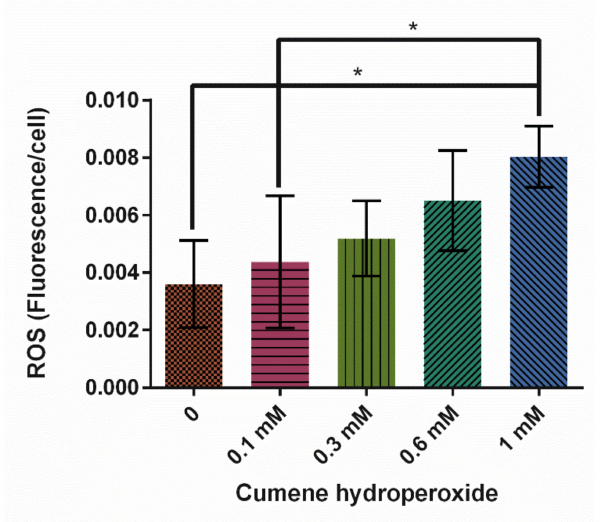
Figure 2. Effect of cumene hydroperoxide on average reactive oxygen species (ROS) levels in D. discoideum ± SE ( N = 5). Cumene significantly increased ROS levels as indicated by * ( p = 0.0116). Immunofluorescence analysis was used to determine microtubule morphology within cells treated with 0, 0.3 and 0.6 mM concentrations of cumene hydroperoxide. Increasing cumene concentration significantly decreased the stability of microtubules in D. discoideum